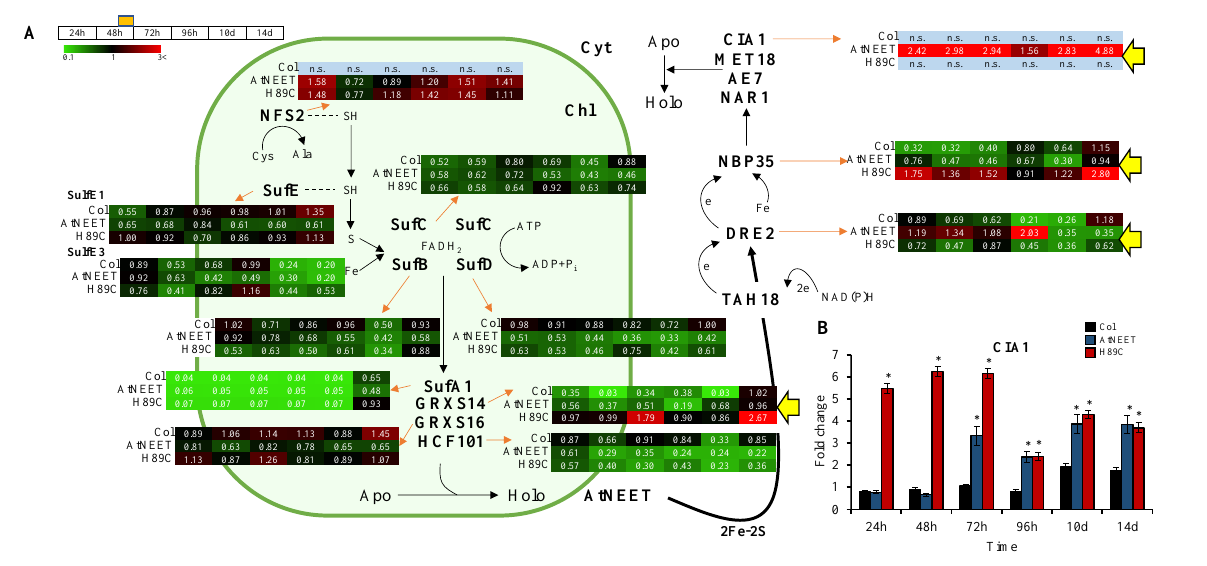
Figure 5. Changes in protein and transcript expression associated with iron–sulfur cluster assembly in the chloroplast and cytosol during the course of the experiment. ( A ) Pathway and heat maps for the expression pattern of different proteins with a significant change in expression (in at least one time point, compared to time 0 h within each genotype) belonging to the iron–sulfur cluster assembly of Arabidopsis at the different time points. ( B ) Steady-state transcript expression levels of CIA1 in Col, AtNEET, and H89C plants at the different time points. Yellow arrows highlight the proteins of interest at the different points. All experiments were repeated at least three times with similar results. Asterisks (*) denote statistical significance with respect to control (Col) at p < 0.05 (Student t -test, SD, n = 5). Abbreviations used: AE7, AS1/2 Enhancer 7; Apo, apo-protein; Chl, chloroplast; CIA1, Cytosolic Iron–Sulfur Protein Assembly 1; Cyt, cytosol; DRE2, Homolog of Yeast DRE2; e, electron; GRXS14, Glutaredoxin S14; GRXS16, Glutaredoxin S16; HCF101, High-Chlorophyll-Fluorescence 101; Holo, holo-protein; MET18, Homolog of Yeast MET18; NAR1, Homolog of Yeast NAR1; NBP35, Nucleotide Binding Protein 35; NFS2, Nifs-Like Cysteine Desulfurase 2; n.s., not significant; SufA1, Sulfur A1; SufB, Sulfur B; SufC, Sulfur C; SufD, Sulfur D; SufE, Sulfur E; TAH18, diflavin reductase.